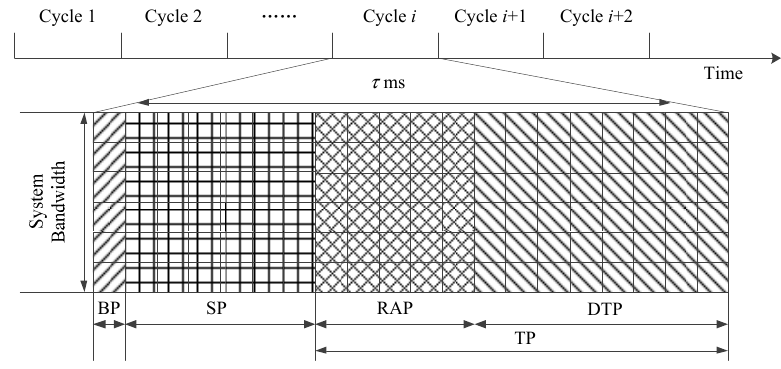
Figure 2. Frame structure of the proposed hybrid S-ALOHA/TDMA MAC protocol.